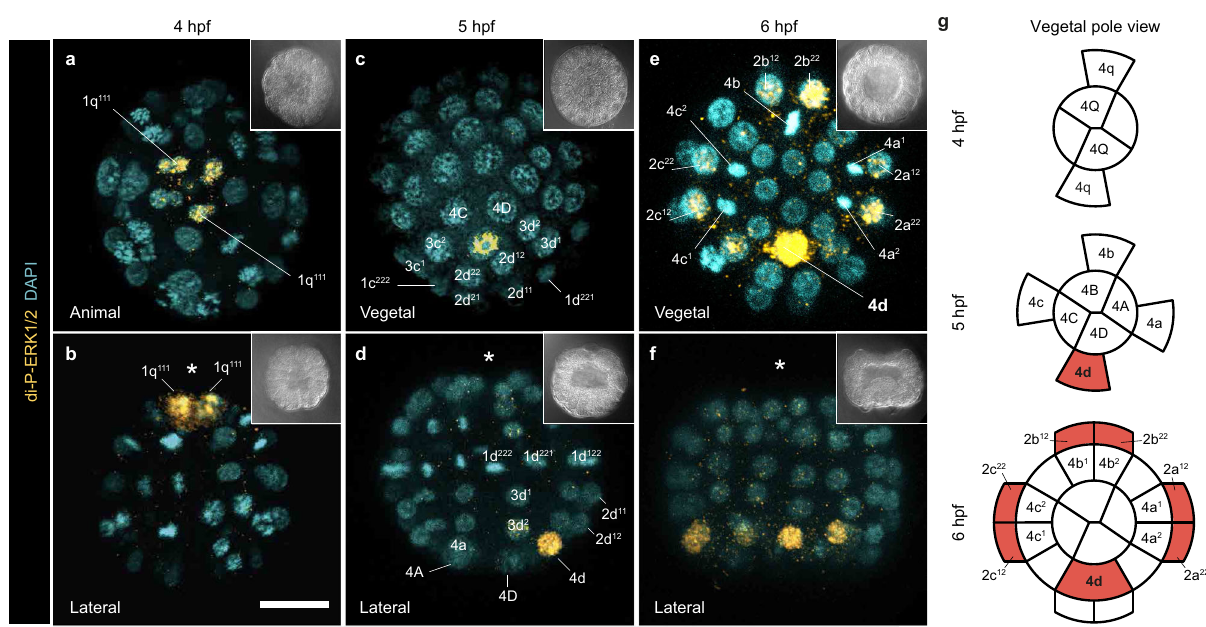
Fig. 2 Di-phosphorylated ERK1/2 is enriched in the 4d micromere in O. fusiformis . a – f z-stack projections of whole-mount embryos at 4-, 5-, and 6-h post fertilisation (hpf) stained against active di-phosporylated-ERK1/2 (di-P-ERK1/2; yellow) and nuclei (DAPI). At 4 hpf ( a , b ), di-P-ERK1/2 is enriched in four animal cells (1q 111 ). At 5 hpf ( c , d ), di-P-ERK1/2 signal is in a single cell (the 4d micromere; see Supplementary Fig. 1), while active ERK1/2 occurs in six cells of the 2a-c lineage and the 4d cell at 6 hpf ( e , f ). Insets in a – f are bright- fi eld images of the corresponding stacks. g Schematic representation of the vegetal pole during birth and fi rst division of the fourth micromere quartet in O. fusiformis . In red, enriched di-P-ERK1/2 signal. In d and f , the asterisks point to the animal pole. Descriptions for a – f are based on at least ten embryos per stage, from a minimum of two biological replicates. Scale bars are 50 μ m. Drawings in g are not to